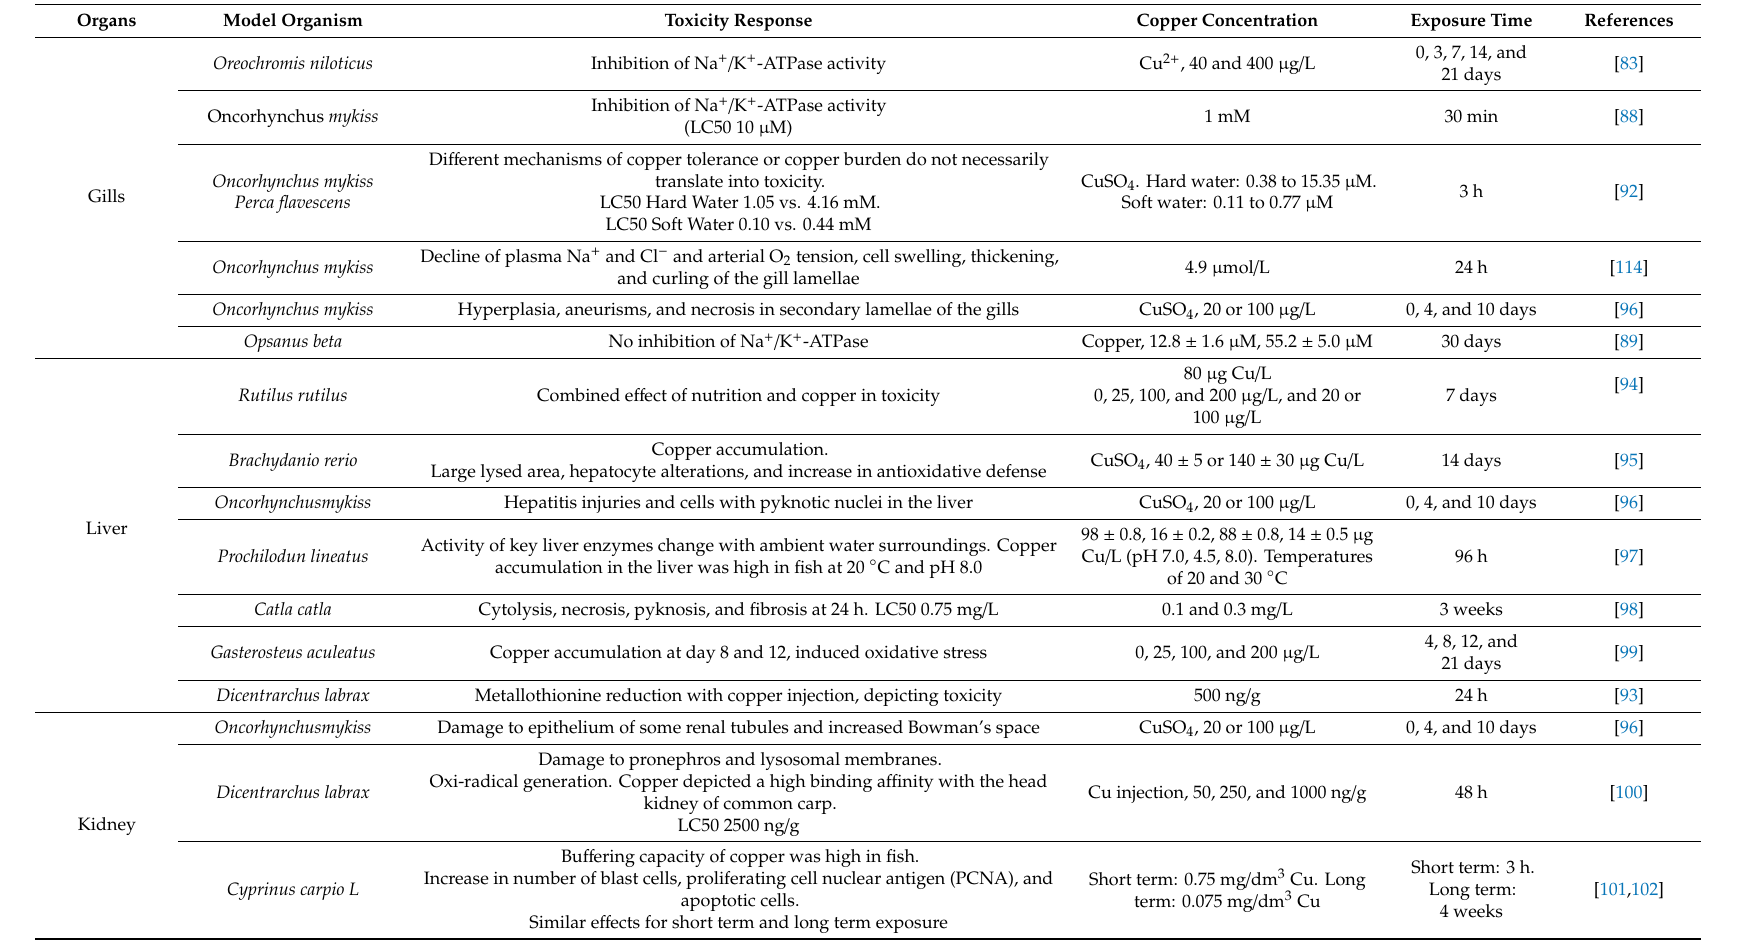
Table 1. Summary of copper ion toxicity in fish based on target